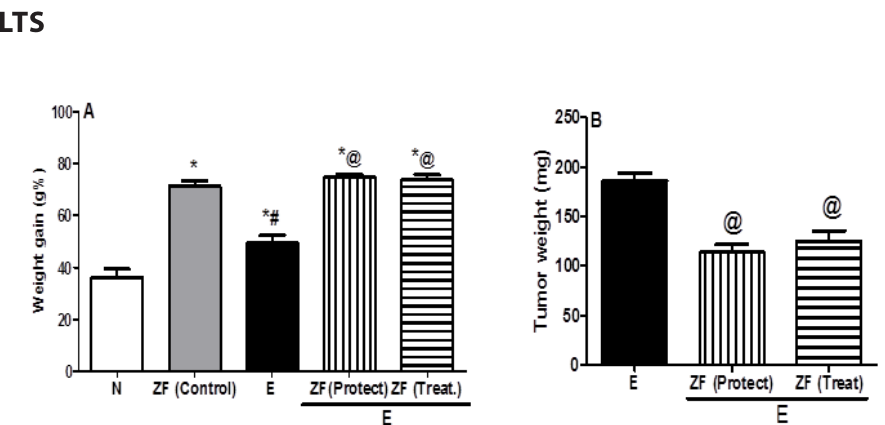
FIGURE 1 - Effect of ZF on percentage body weight gain and tumor weight